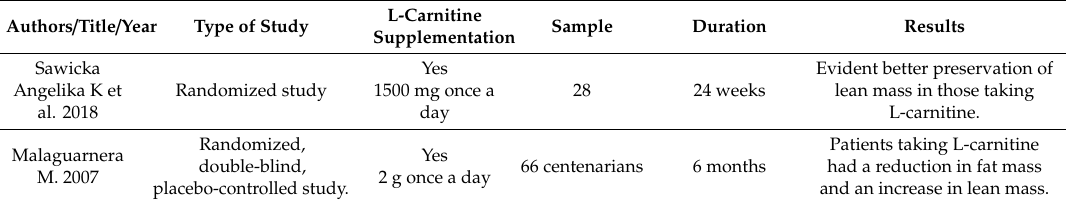
Table 6. Summary of studies on l -carnitine considered in this narrative